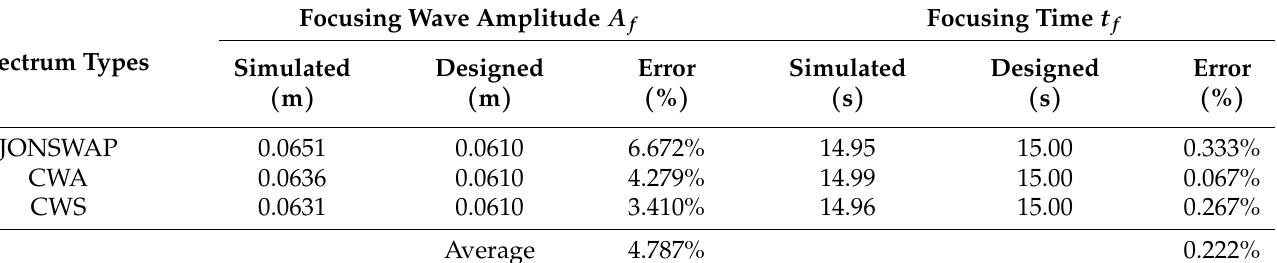
Figure 12. The comparison of free surface between three spectra at the focusing time. ( a ) JONSWAP spectrum. ( b ) CWA spectrum. ( c ) CWS spectrum. Table 3. Comparison of the focusing wave amplitude and the focusing time between numerical results and designed